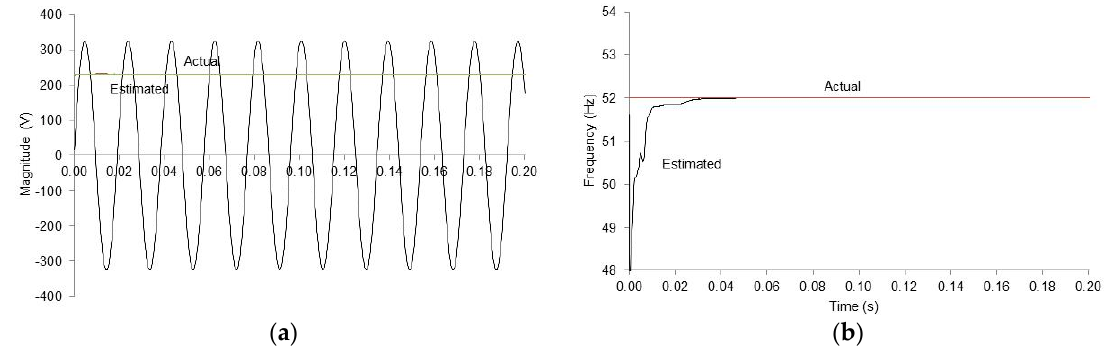
Figure 1 . ( a ) Estimated phasor magnitude and ( b ) frequency in the case of a 230 V magnitude and 52 Hz voltage waveform.